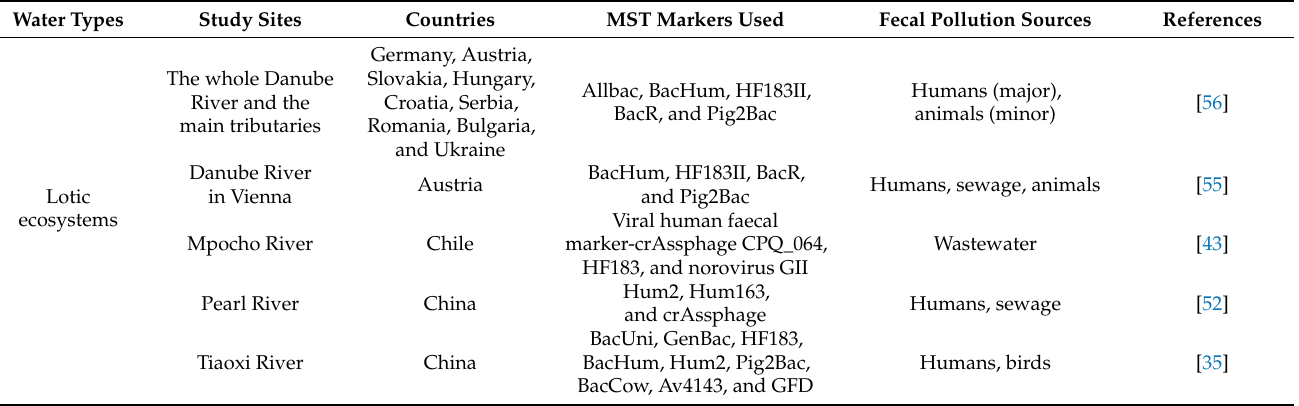
Table 1. MST studies using various host-associated genetic markers for source(s) determination of fecal contamination in distinct water